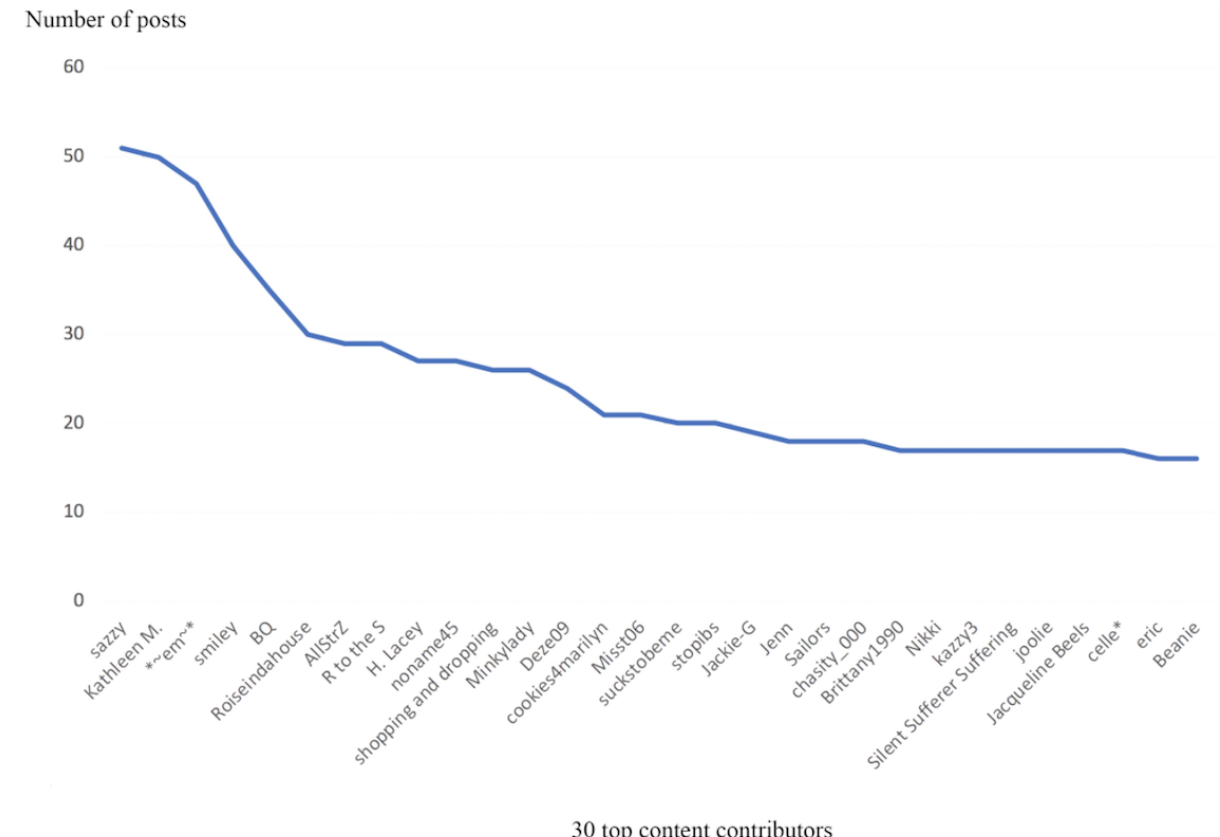
Figure 5. Plot of number of posts made by the 30 top content